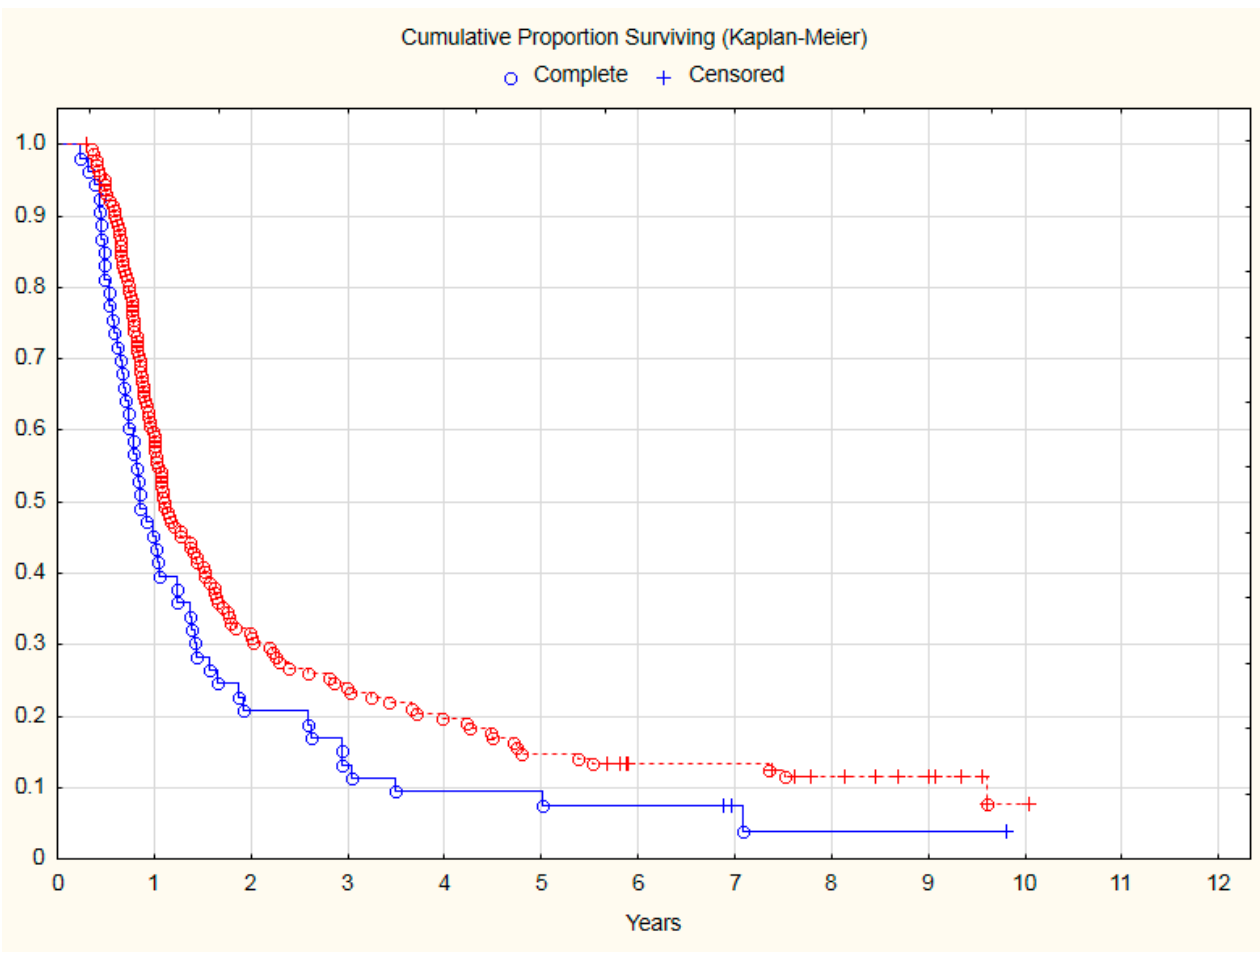
Figure 1. The comparison of OS between NSCLC patients with KPS deterioration during chemora- diotherapy (blue line) and patients with stable performance status (red line).Median of OS: 18.77 months vs. 28.23 months. Risk of mortality: HR = 1.42; 95% CI: 1.02–1.99; p = 0.04.